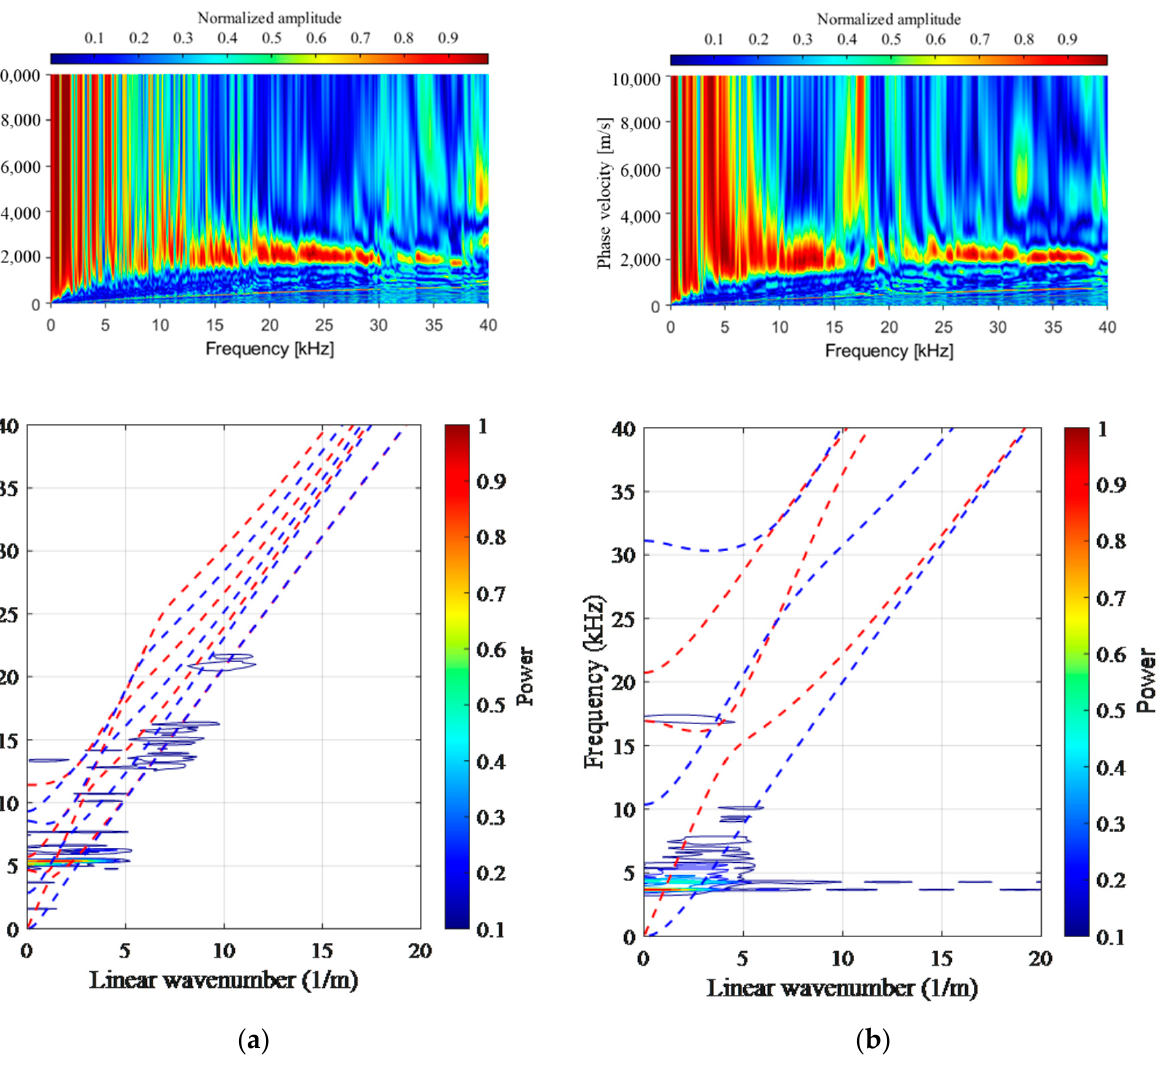
Figure 11. Phase velocity dispersion curves for normal and delamination defects. ( a ) Intact 400 mm (N400); ( b ) acrylic plate defect 110 mm (E110) .